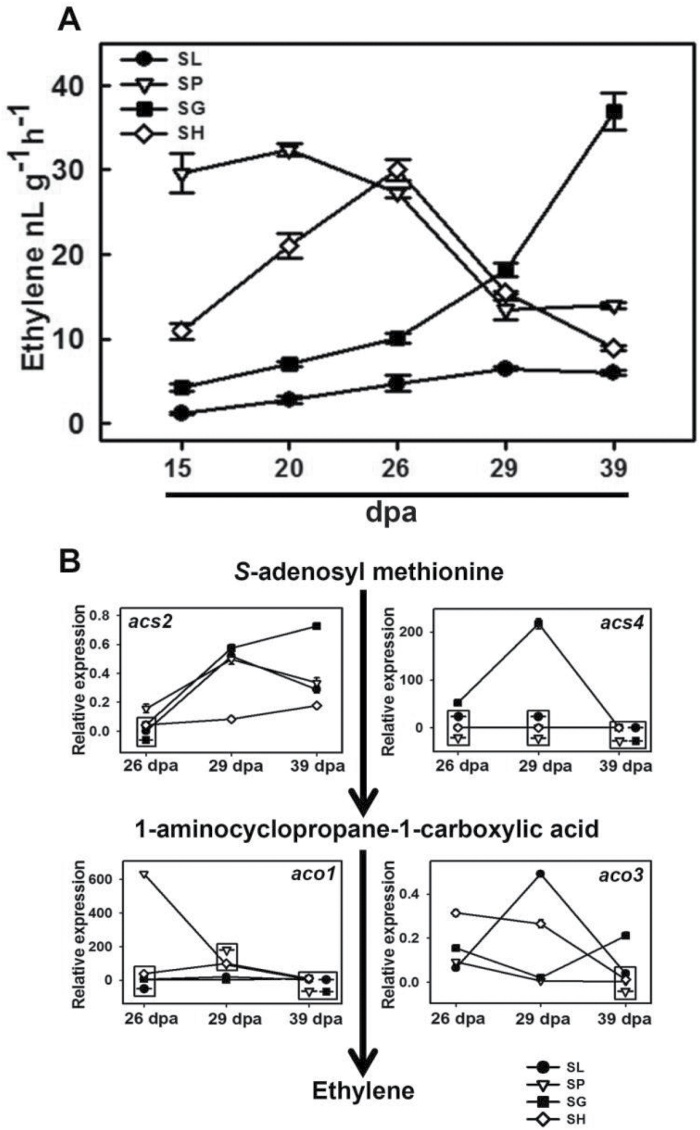
Ethylene emission and transcript levels of ethylene biosynthesis genes in tomato and wild species. (A) Fruits were harvested at the indicated time points, and ethylene emission was measured. Data are means±SE (n=5), P≤0.05 and presented in Table S7). (B) The relative transcript levels of acs2, acs4, aco1, and aco3 in 26, 29, and 39 dpa fruits were measured after normalization with β-actin and ubiquitin (Table S7 shows means±SE (n=3) along with corresponding P-values). The overlapping symbols are enclosed in a box. Error bars smaller than the symbol are masked underneath.